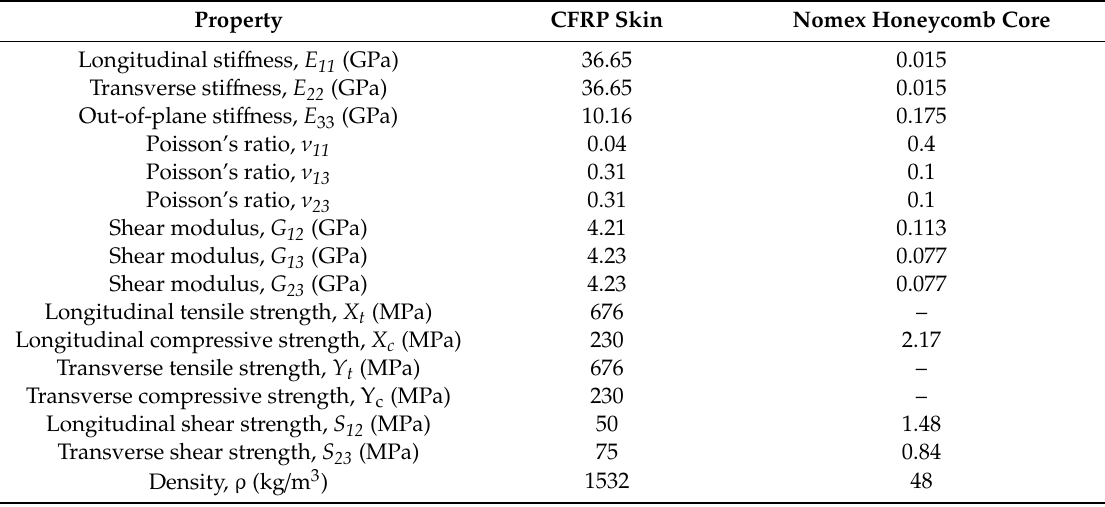
Table 1. Property parameters of carbon fiber reinforced polymer (CFRP) skin and Nomex